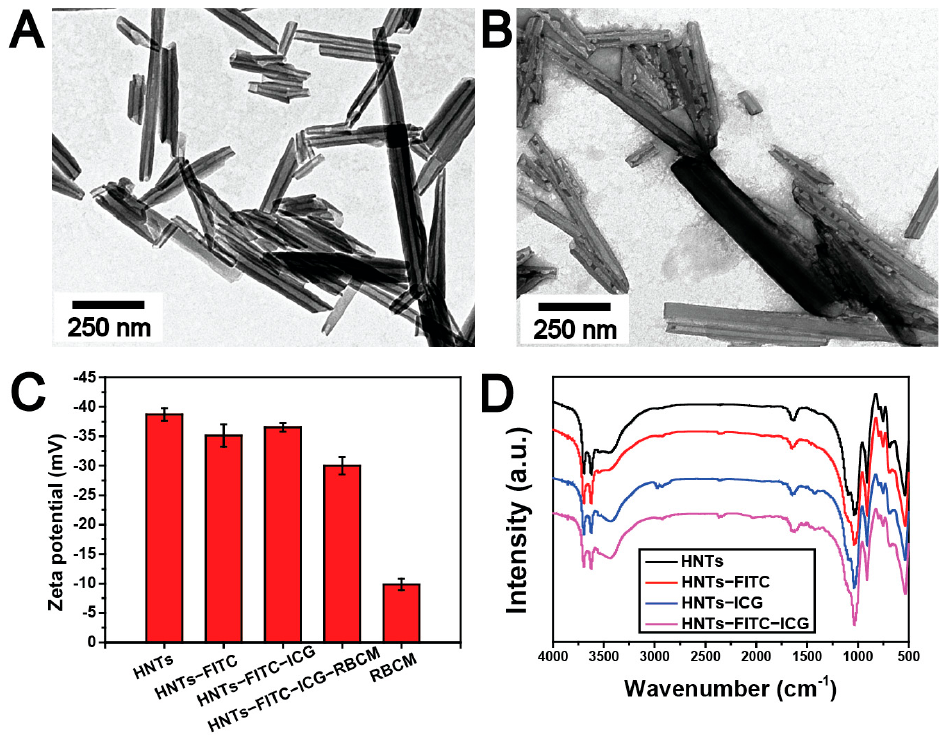
Figure 1. TEM images of HNTs ( A ) and HNTs ‐ FITC ‐ ICG ‐ RBCM ( B ), zeta potential ( C ) of HNTs, HNTs ‐ FITC, HNTs ‐ FITC ‐ ICG, HNTs ‐ FITC ‐ ICG ‐ RBCM and RBCM, FTIR spectrum ( D ) of HNTs, HNTs ‐ FITC, HNTs ‐ ICG and HNTs ‐ FITC ‐ ICG.